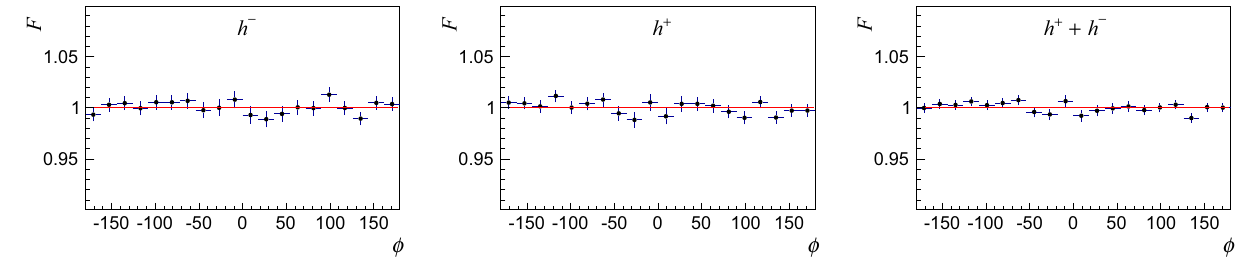
Fig. 8 The φ -dependence of the weighted sums of double ratios F (φ) for 2006 data: h − , h + and h + + h − . The solid (red) lines represent the results of fits by